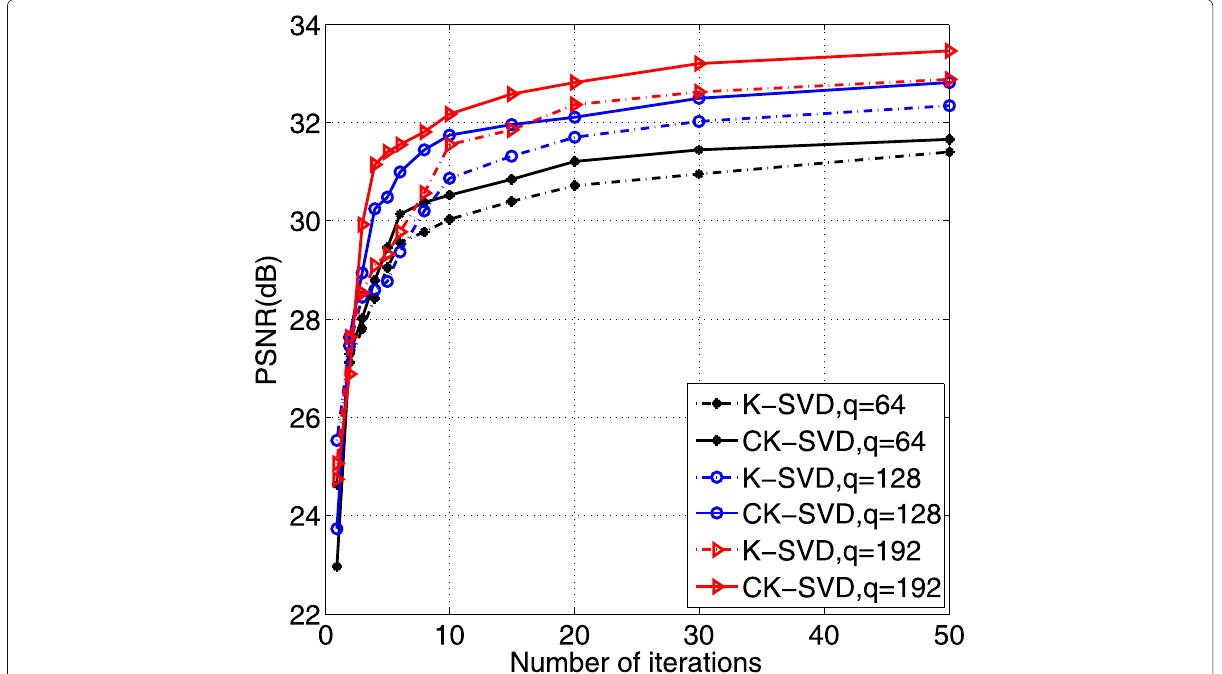
Fig. 7 PSNR of the sparse representations of test images versus the number of iterations, k = 4